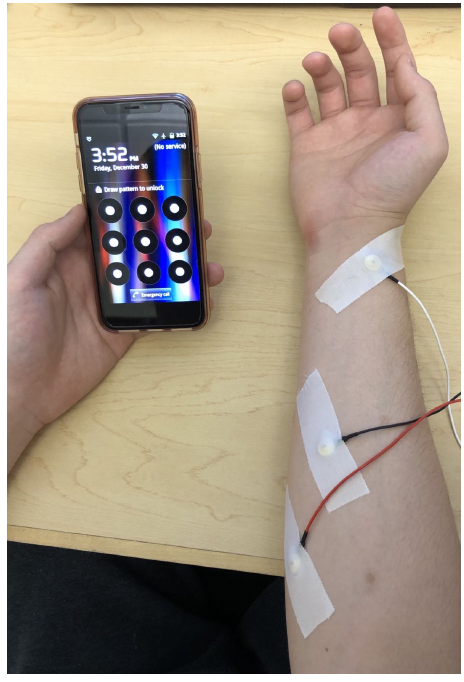
Figure 3. Experiment setting.